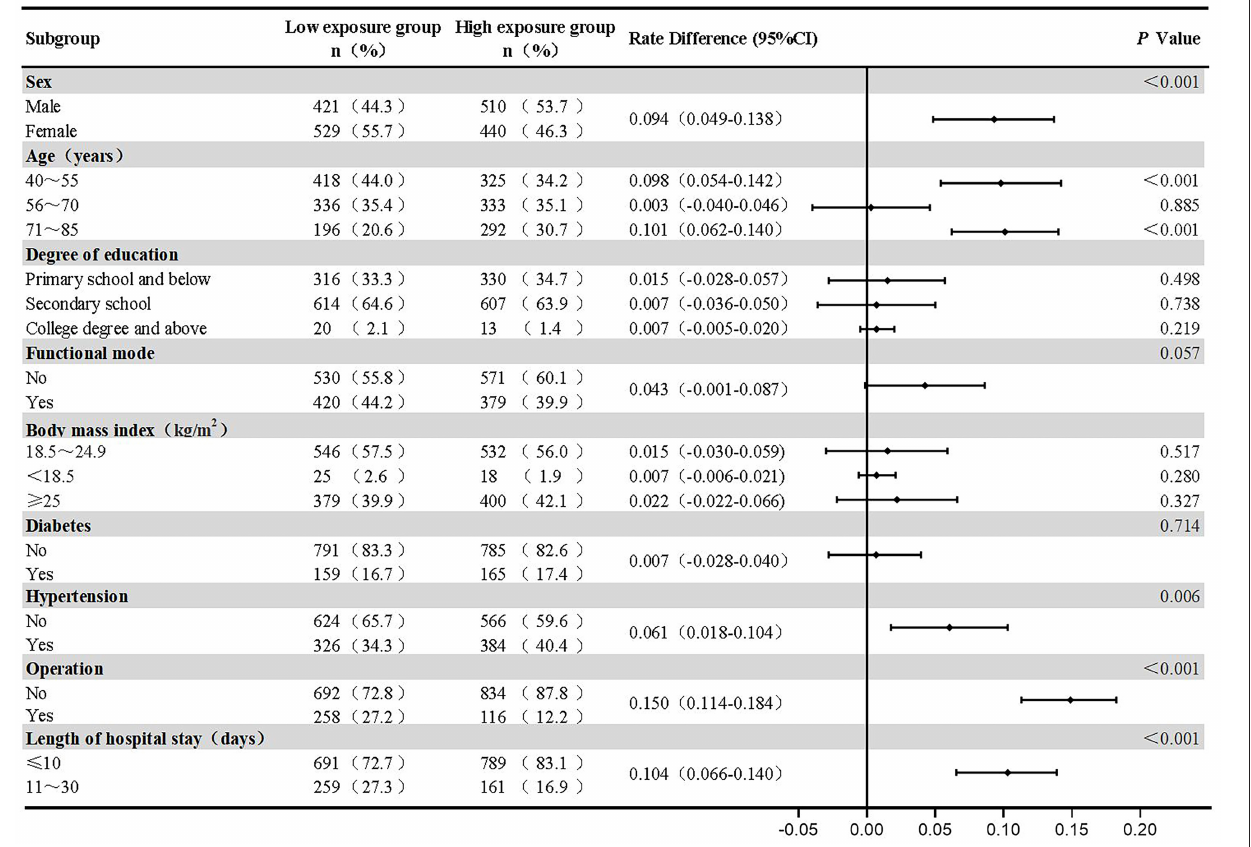
were diagnosed with frozen shoulder, for a cumulative incidence rate of 7.1% (RR =